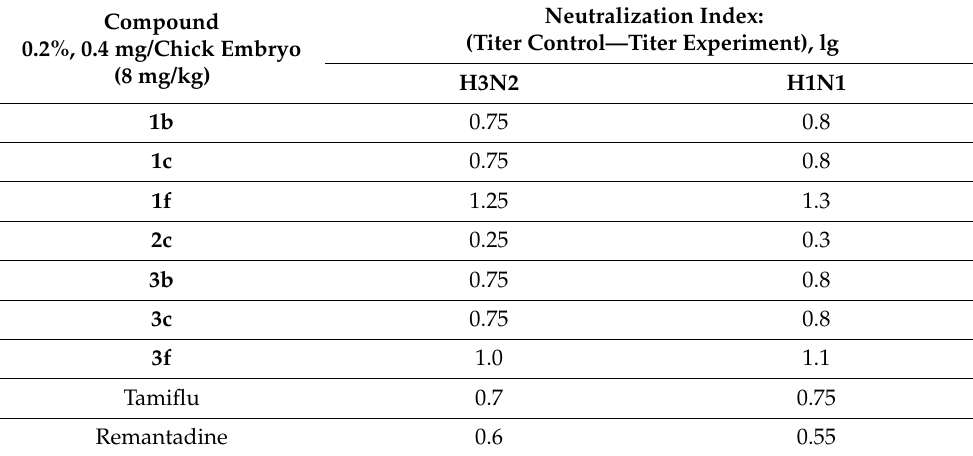
Table 6. Virucidal activity of alkaloid-type drugs.